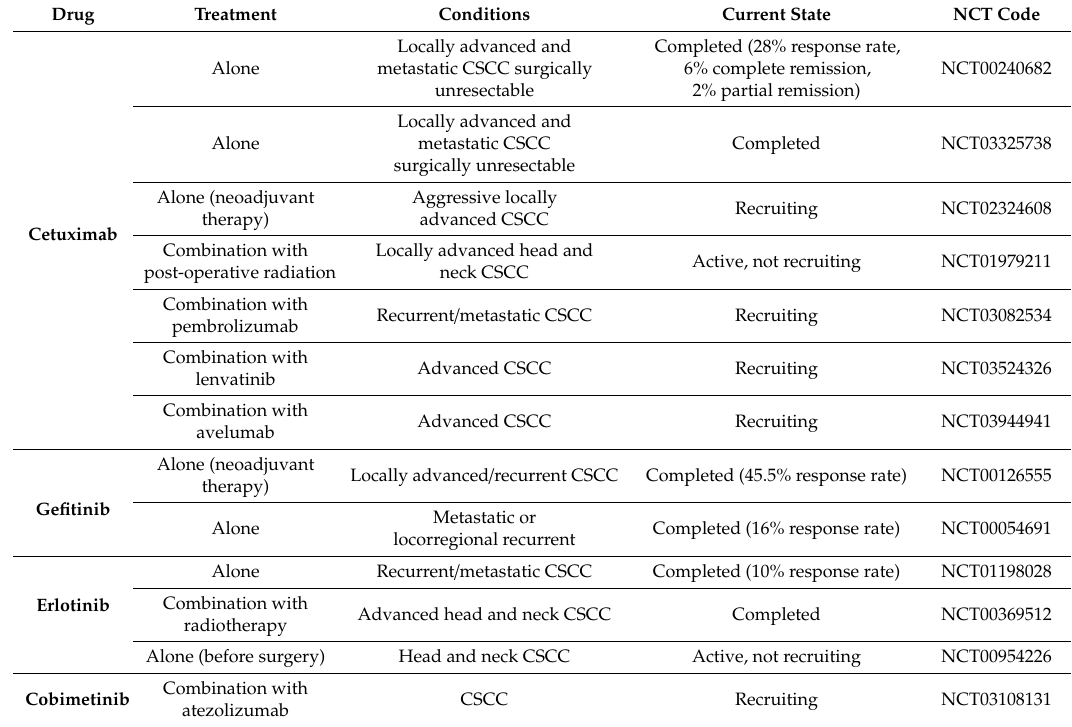
Table 1. Clinical trials of targeted therapies in cutaneous squamous cell carcinoma (CSCC)